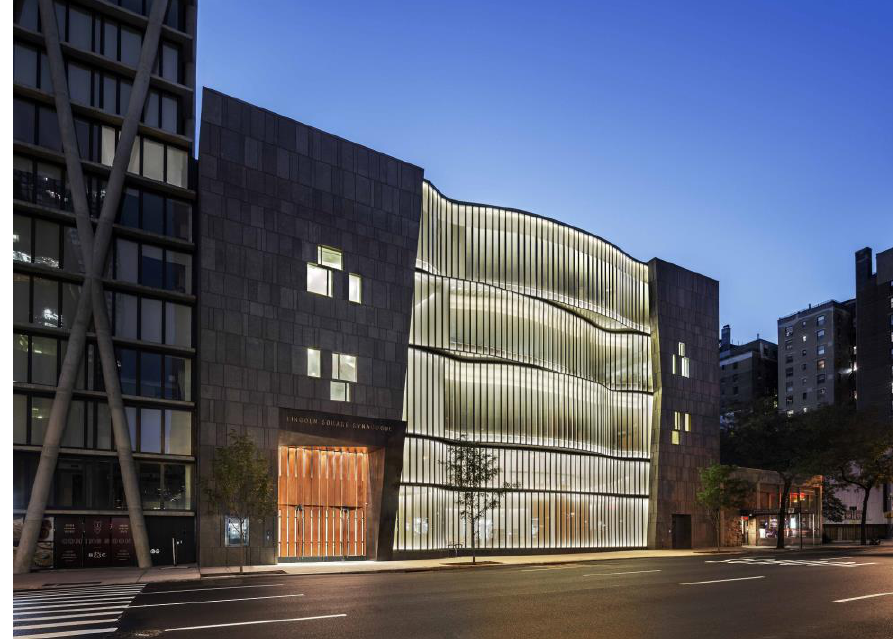
Figure 3. Lincoln Square Synagogue, 2005–2013, Cetra/Ruddy. Photo David Sundberg/ESTO. Exterior at dusk.